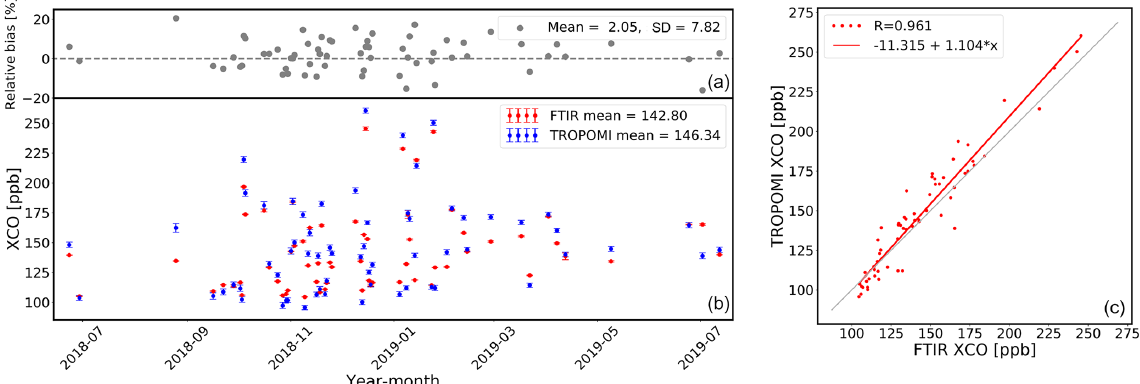
Figure 15. (a, b) Time series of daily mean co-located TROPOMI and ground-based FTIR XCO data at Xianghe (b) and the relative bias between them (a) . The error bars are the relative SDs of co-located TROPOMI and FTIR XCO data. (c) Correlation plot between co-located daily mean XCO data from TROPOMI and the FTIR instrument at